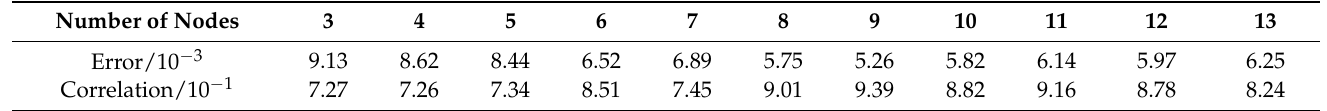
Table 2. The MSE and correlation of different node quantities in the hide layer.